Question: In one sentence, what is this figure communicating?
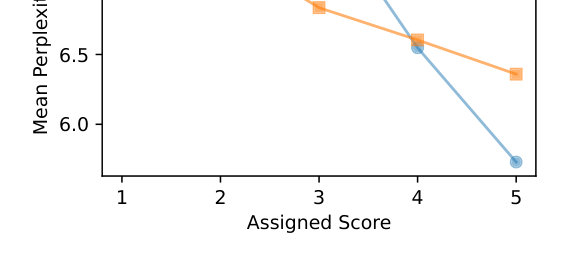
Answer: Average perplexity for each rating by GPT- 4 and Experts. Summaries are grouped by evaluation scores (as assigned either by Experts or by GPT-4). GPT- 4 exhibits a disproportionate bias toward low perplexity summaries compared to expert annotators, demonstrat- ing a familiarity bias.